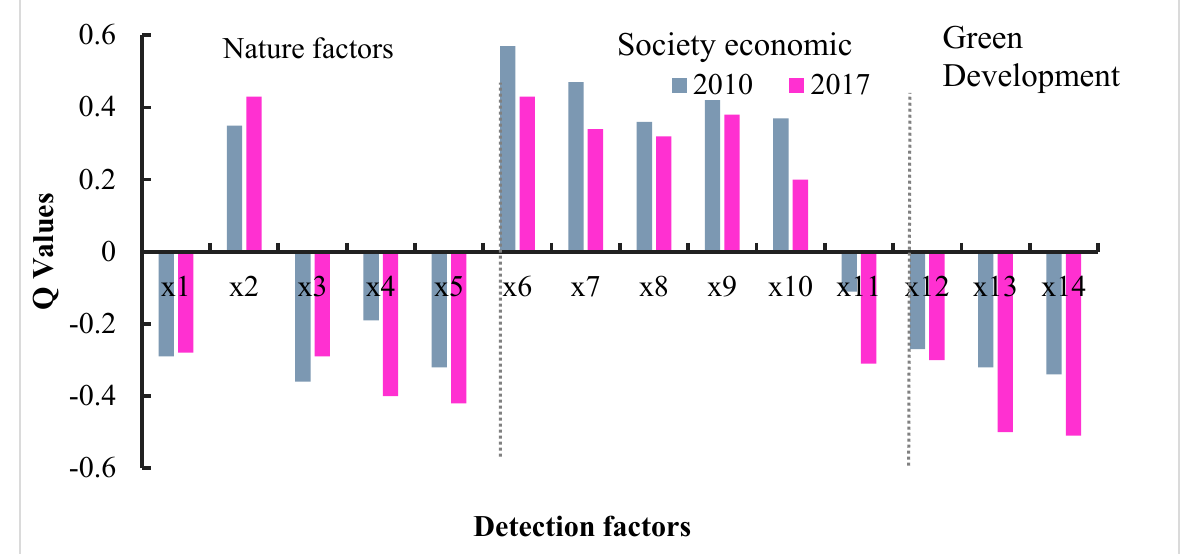
Figure 5. The geographic detector model analysis on the contribution of each single factor to regional PM 2.5Cement . X1 ….X14 were the 14 factors for natural, society economical, and green development aspects in Table 1.